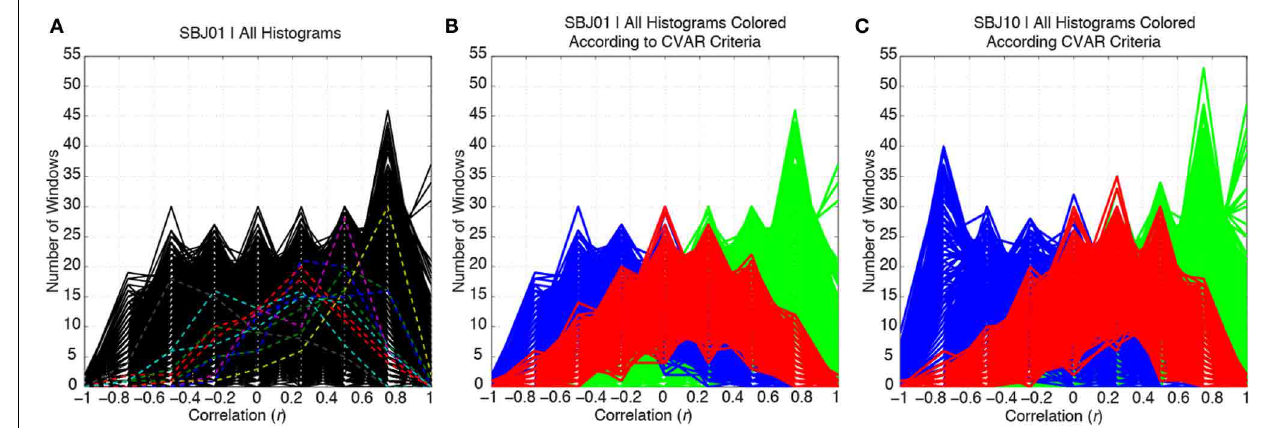
FIGURE 5 | (A) Distributions of correlation values across time for all the connections in a representative subject are depicted in black. To highlight the mostly uni-modal shape of individual histograms, 11 randomly selected histograms are highlighted using dashed colored lines. (B) Same histograms as in (A) , but this time each histogram is colored according to the